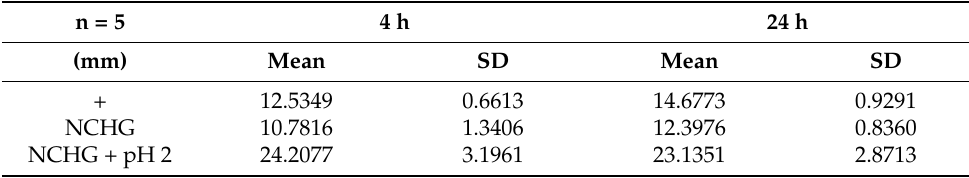
Table 2. Diameters of inhibition zones in antibiotic effect investigations.